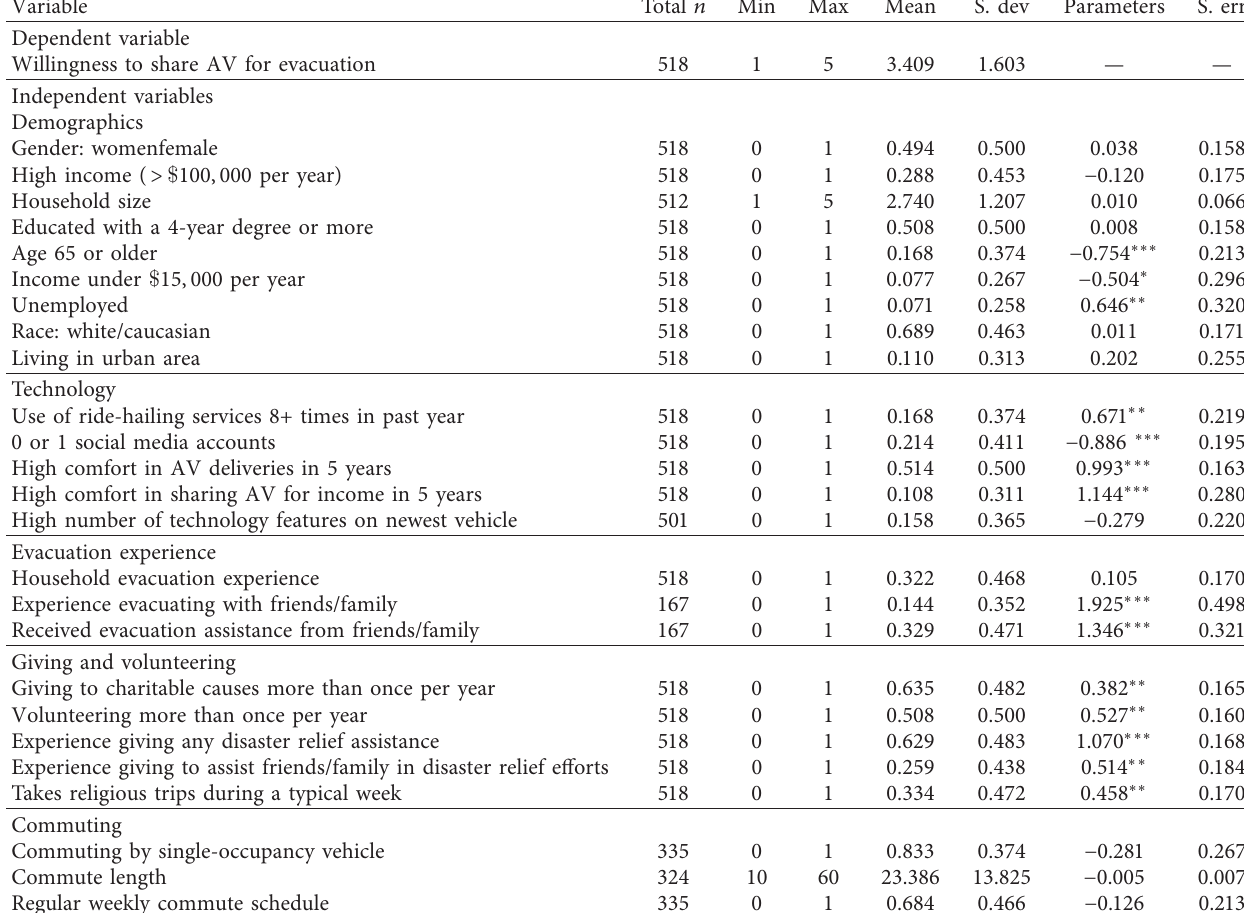
Table 1: Summary statistics of selected variables and relationship with evacuation sharing